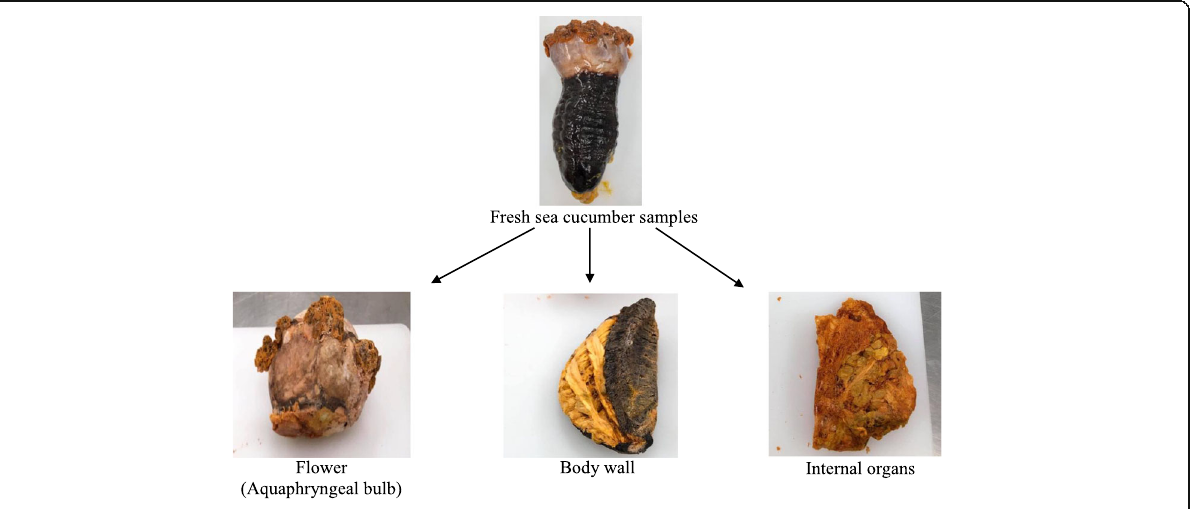
Fig. 1 Sea cucumber sample preparation